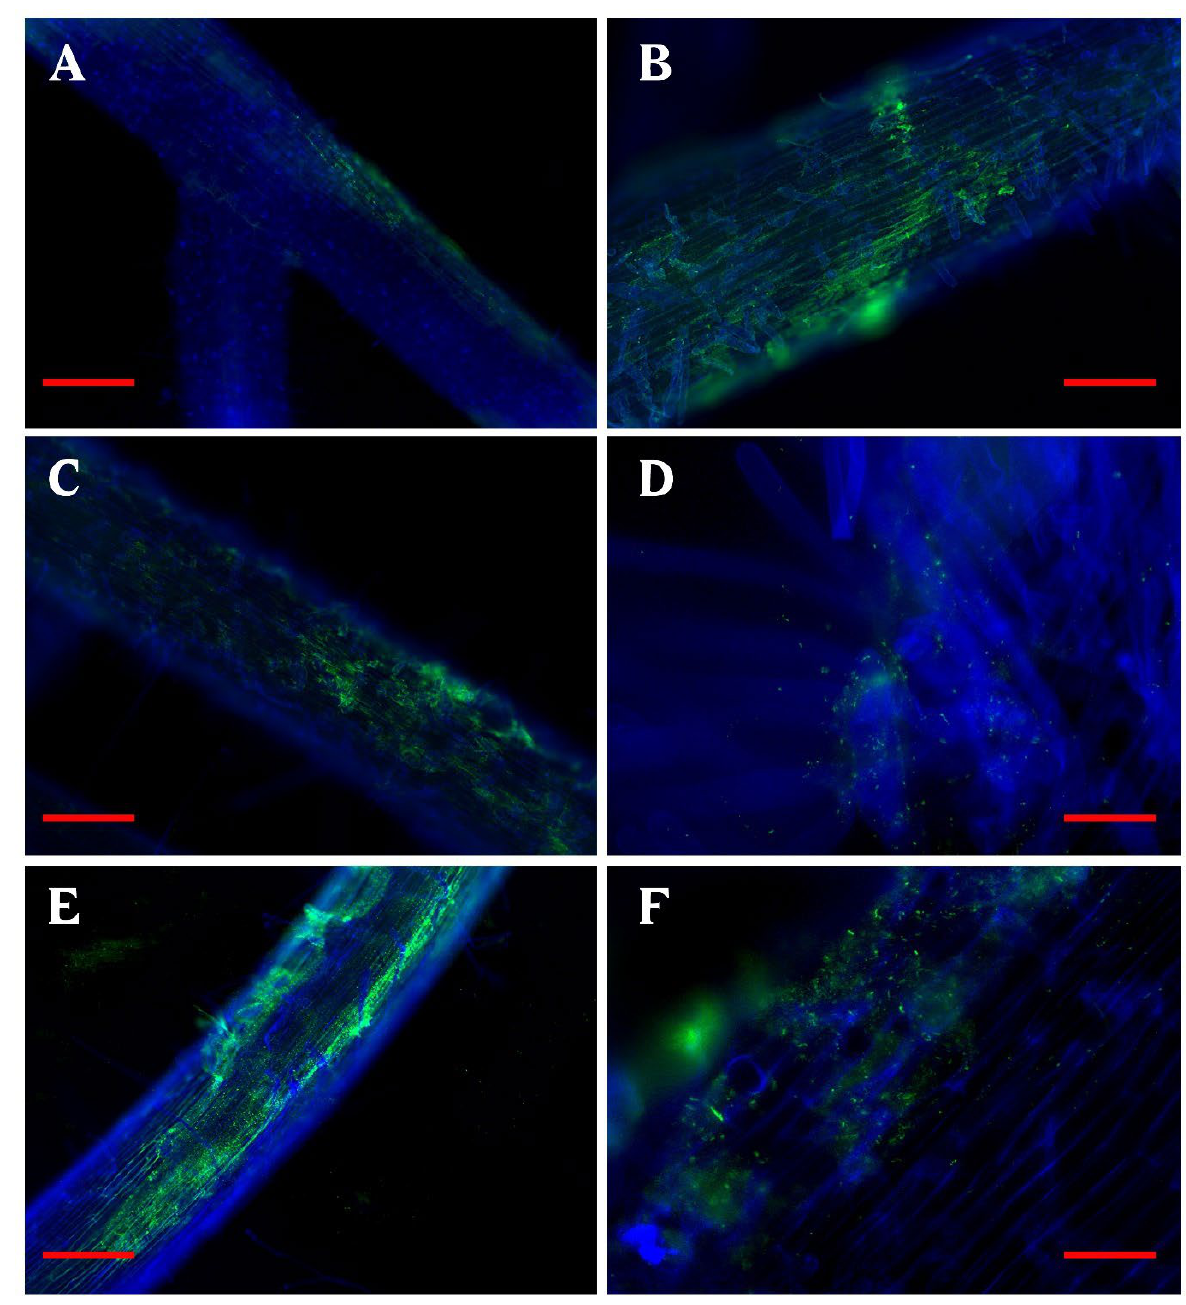
Figure 6. Fluorescence optical micrographs of roots of blueberry seedlings colonized by QSE20 ( A ) 500 µm, ( B) 200 µm, QSE62 ( C ) 500 µm, ( D ) 75 µm and QSE79 ( E ) 500 µm, ( F ) 75 µm. In green, inmunolocated cells of studied strains, and in blue, root cells stained with calcofluor white.